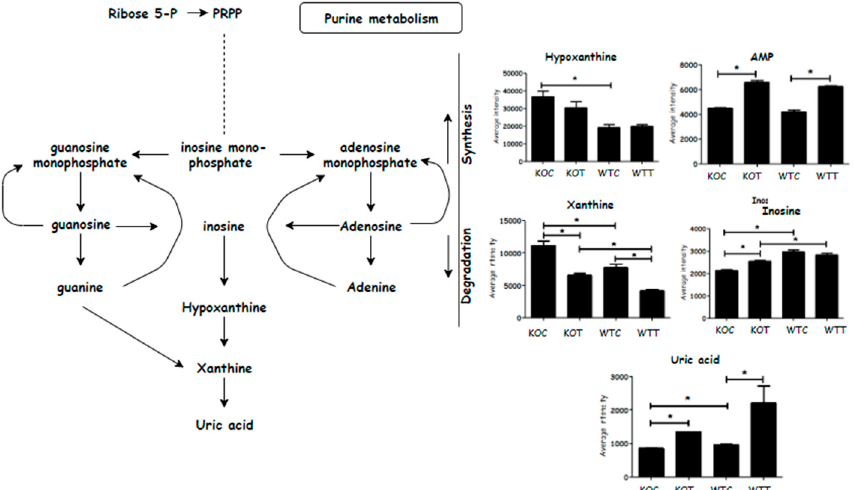
Figure 7. Purine substrates that were altered due to oxLDL treatment. AMP: adenosine monophosphate; PRPP: Phosphoribosyl pyrophosphate. KOT: TSPO knockout cells with the treatment of oxLDL; KOC: TSPO knockout cells without the treatment of oxLDL; WTT: Wildtype cells with the treatment of oxLDL; WTC: Wildtype cells without the treatment of oxLDL. * Indicates that difference is significant with corrected p < 0.05. Error bar is the standard error of the mean